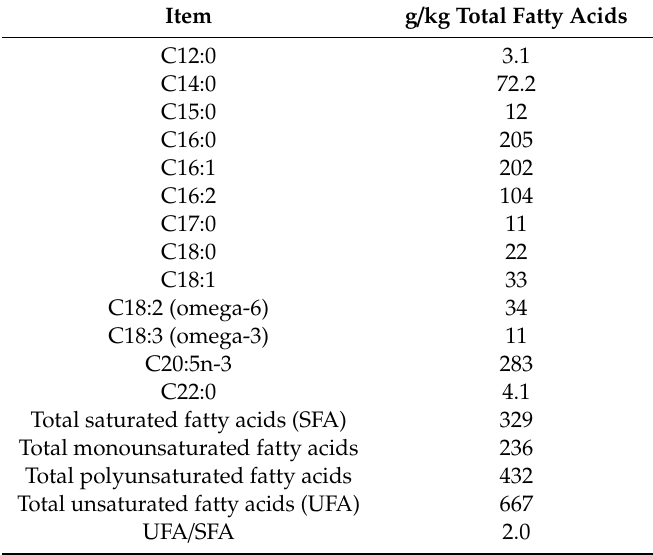
Table 2. Fatty acids profile of N. oculata